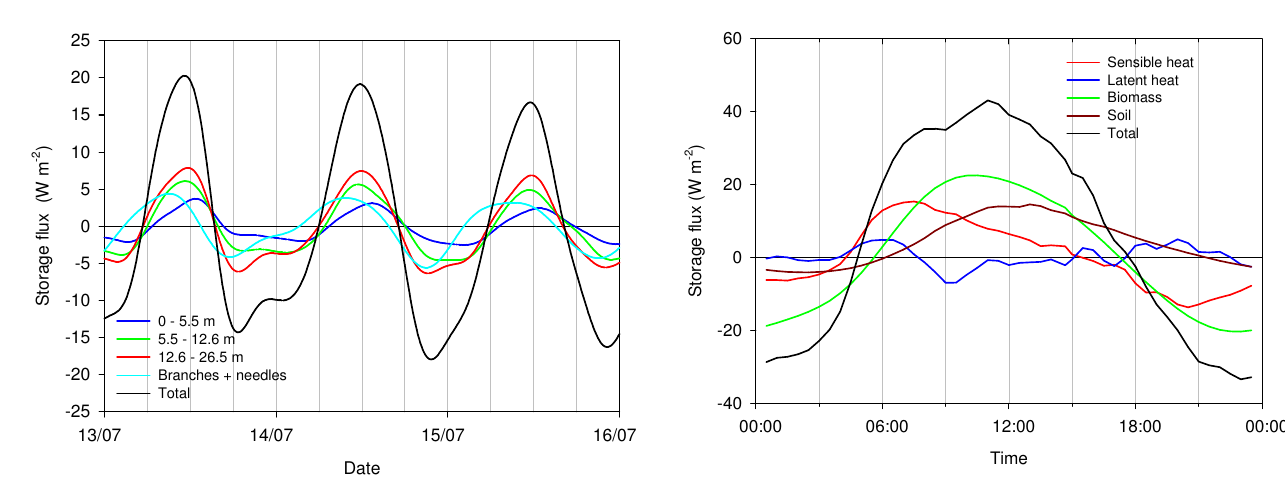
Fig. 5. The average storage flux during June–July 1995 divided into different components; the sensible and latent heat storage in stand air, the soil and the biomass, respectively.